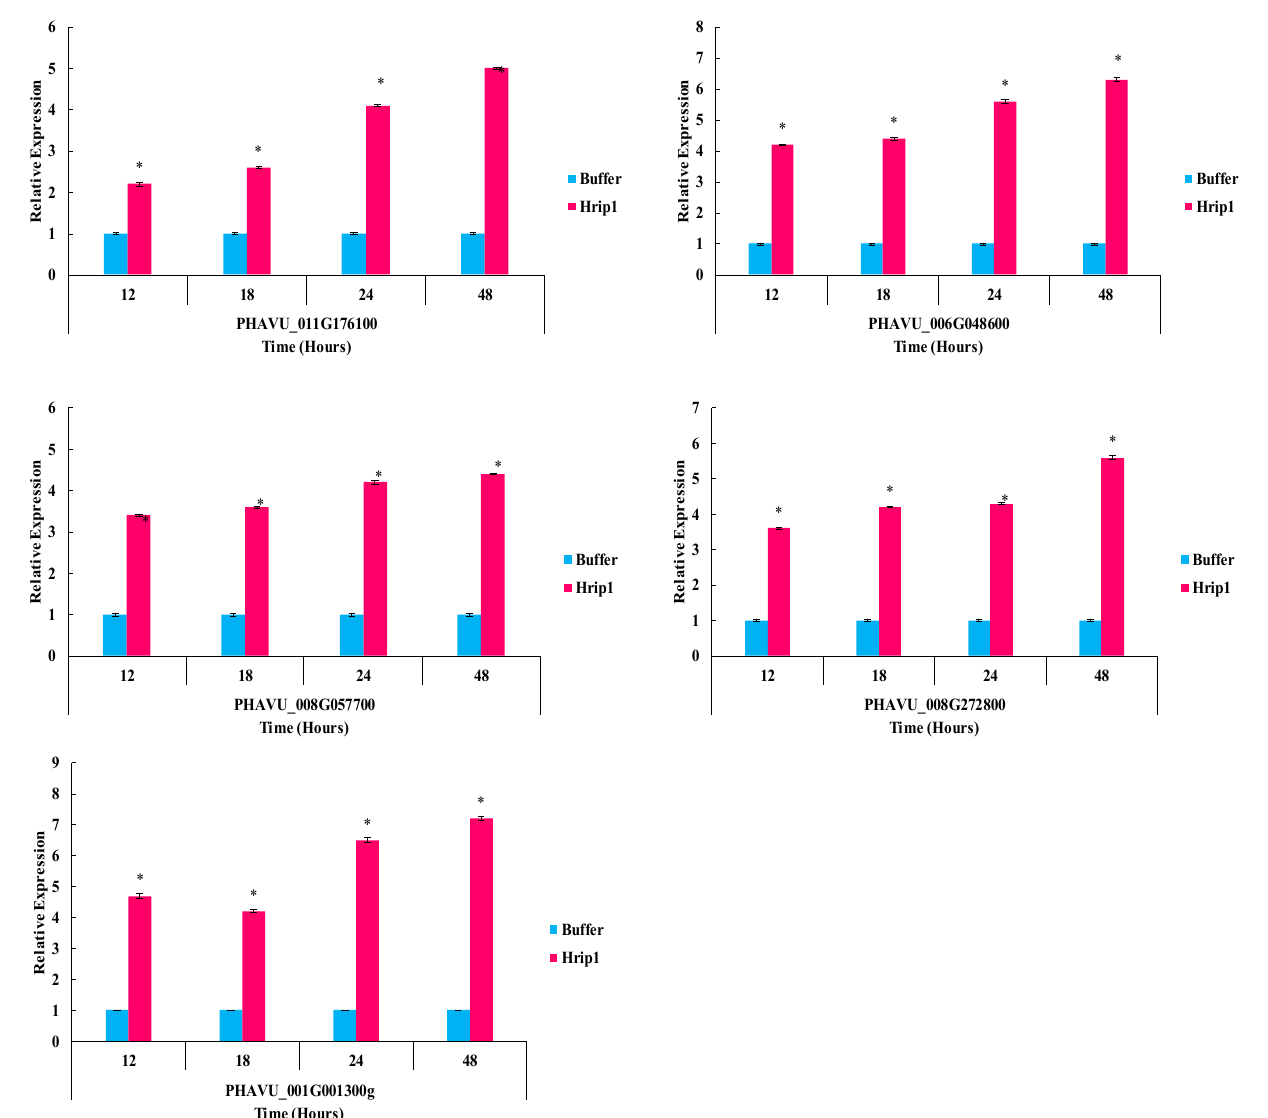
Figure 8. After Hrip1 elicitor treatment and aphid infestation, the relative expression of plant defense from the SA pathway was detected. An asterisk next to each gene indicates a significant difference from the buffer control ( p < 0.05).